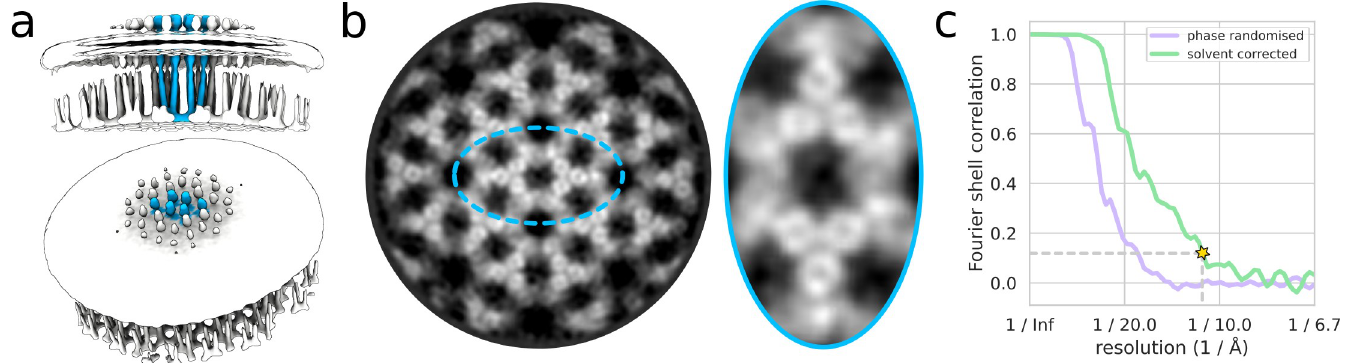
Fig 6. A (nominally) 11- Å reconstruction of the in situ chemosensory array from 17,484 particles in 48 tomograms of E . coli minicells. The full reconstruction with a pixel size of 7.5 Å /px is shown in (a) with the membrane density superposed at a lower isosurface threshold. The quality of the density is visible in a slice through the map reconstructed with a pixel size of 2.24 Å /px and filtered to 11 Å (b, left). Holes are clearly visible in the densities of receptor dimers at this resolution (b, right). The gold-standard FSC curve (c) used to estimate the nominal resolution value is shown alongside the phase-randomised masked FSC curve used to validate the mask used for FSC calculation. The data used to produce this figure can be found at http://doi.org/10.5281/zenodo.4783151. FSC, Fourier shell